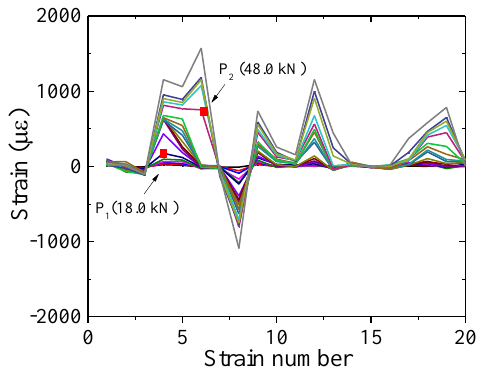
Figure 15. The changing features of strain-based stressing state modes for specimen 1-3.